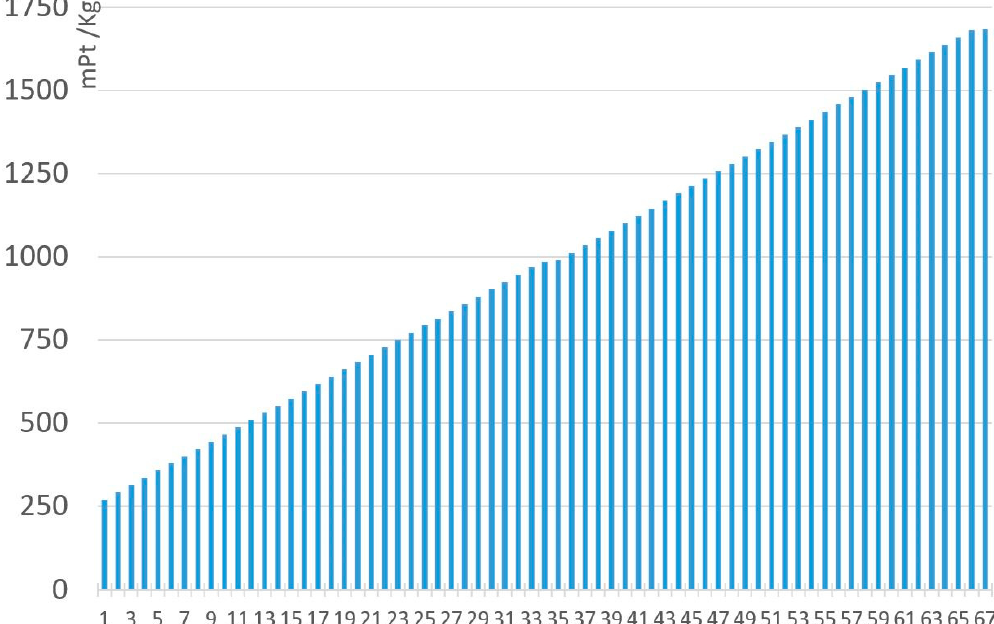
Figure 10. Environmental impact (RMA + Production). of 1 kg NiZn for the 67 ferrites, under the ReCiPe methodology.